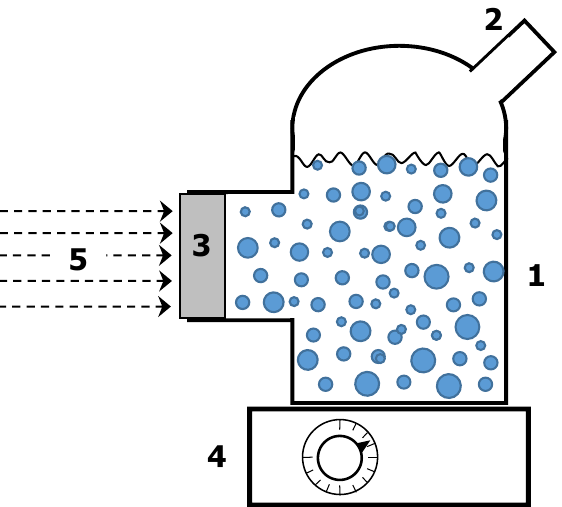
Figure 7. Schematic diagram of biphasic photoreactor showing continuous and dispersed phases. ( 1 ) Custom made photoreactor, ( 2 ) sampling port, ( 3 ) quartz window, ( 4 ) mixer, and ( 5 ) collimated beam of light from the xenon light source.